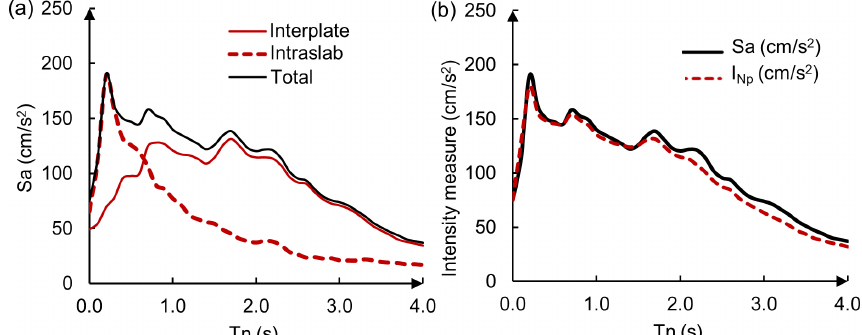
Figure 3. (a) Uniform hazard spectra for CU and (b) uniform hazard spectra of Sa( T 1 ) and I N 5 Probabilistic seismic hazard analysis using I N